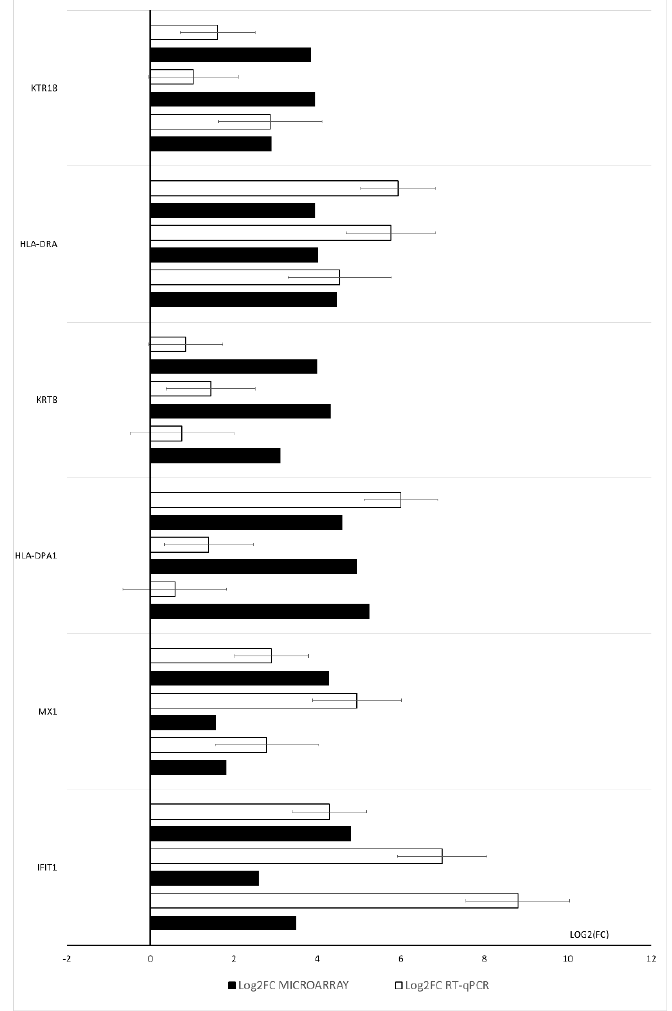
Figure 10. RT-qPCR results. Validation of the microarray results of the six most upregulated genes.